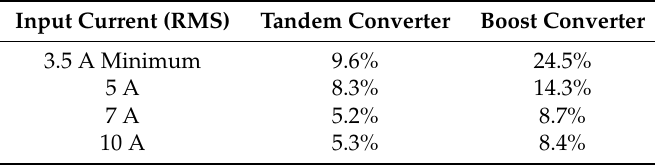
Table 3. THD analysis of the tandem and boost